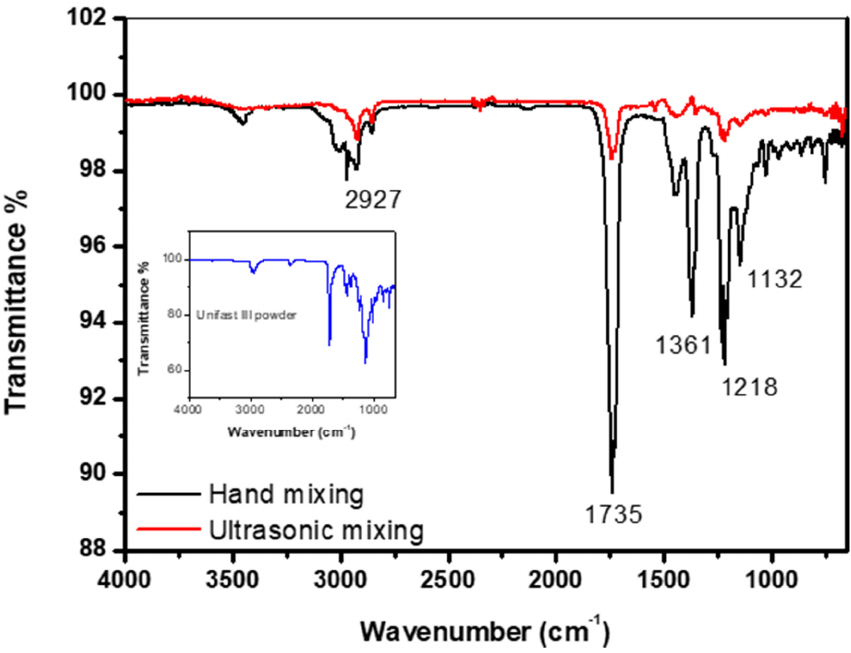
Figure 6. FTIR spectrum of control specimen made by hand and ultrasonic mixing methods as well as the spectrum corresponding to UNIFAST III powder.